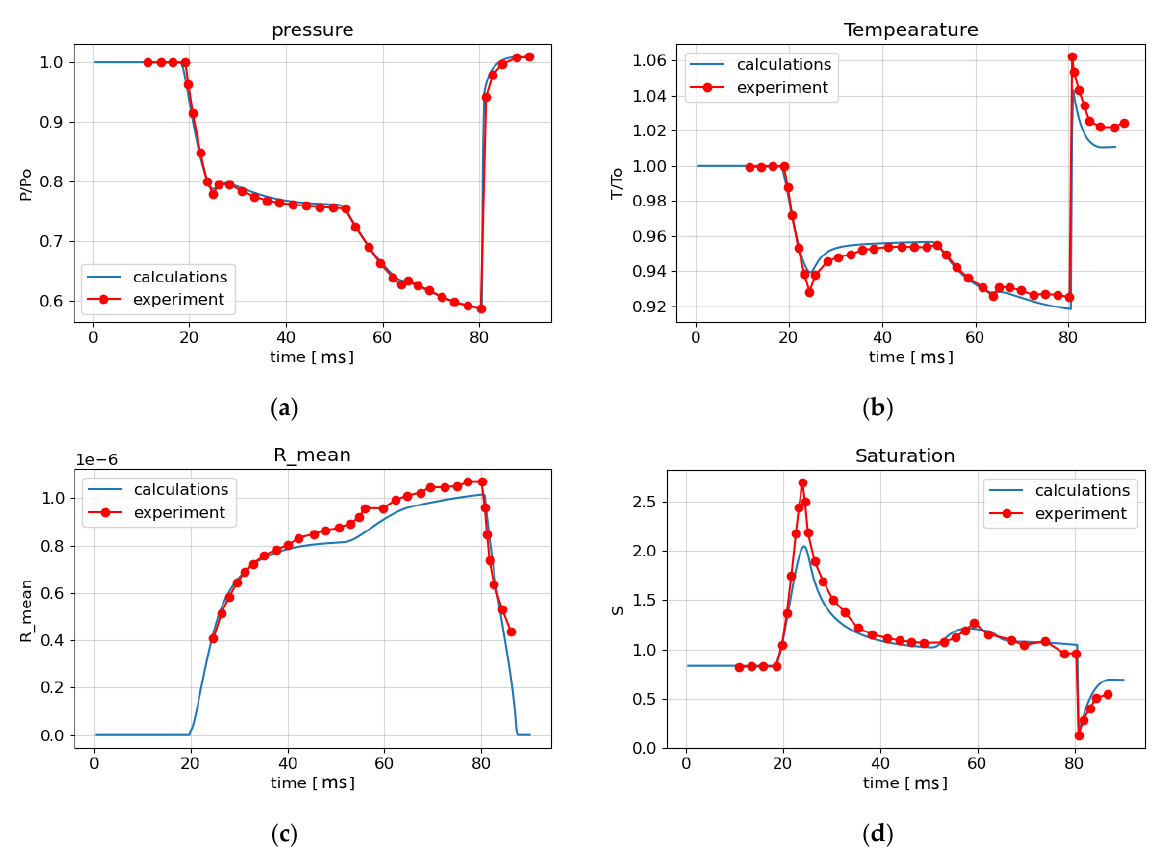
Figure 8. Comparison of experimental results [28] and calculations: ( a ) the pressure; ( b ) the temperature; ( c ) the average particle radius; ( d ) the saturation ratio.